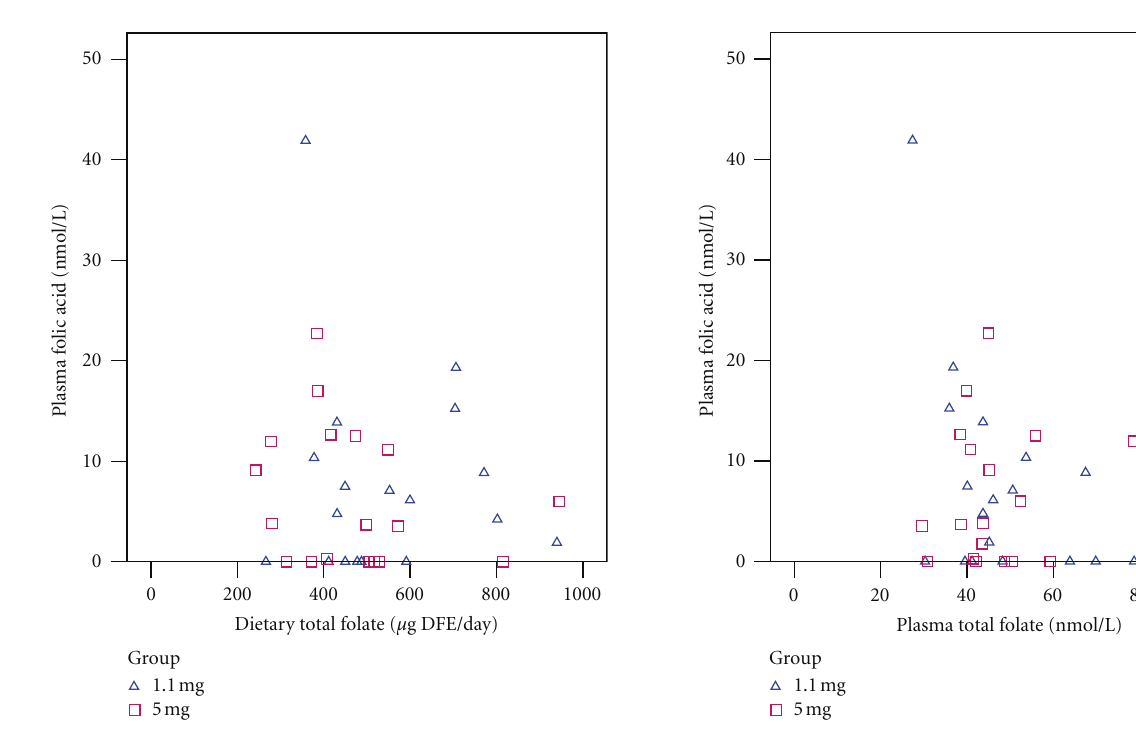
Figure 3: Relationship between plasma folic acid and dietary folic acid intake. 1.1 mg group (triangles): Kendall’s τ b = 0.12, P = 0 . 47. 5mg group (squares): Kendall’s τ b = − 0 . 18, P = 0 . 29. Pooled: Kendall’s τ b = − 0 . 026, P = 0 . 83.